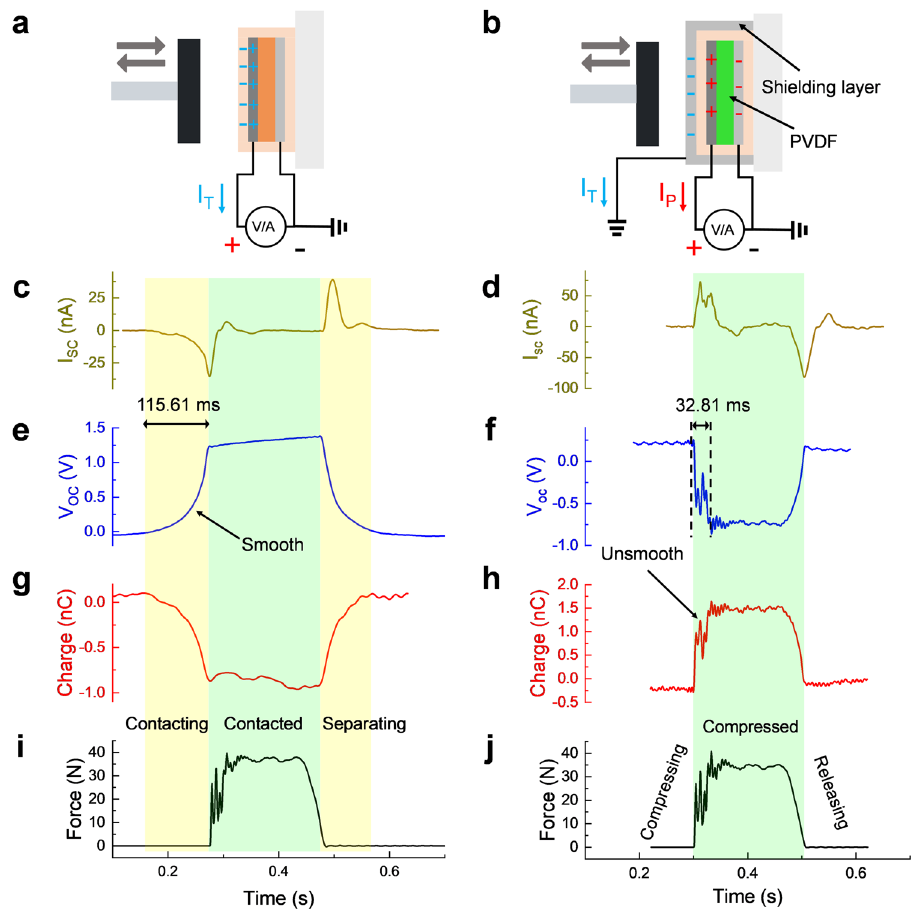
Fig. 3 Using loading force signal to differentiate the sole triboelectric signals and the sole piezoelectric signals. a Schematic diagram of measuring sole triboelectric signals from the PI-based device. Sole triboelectric signals including c short-circuit current, e open-circuit voltage, and g transferred charge are obtained under a certain i force signal, respectively. b Schematic diagram of measuring sole piezoelectric signals from PVDF-based device with a shielding layer. The conductive shielding layer is attached on the device ’ s surface, which can guide the induced triboelectric charges (I T ) fl ow to the ground and only piezoelectric signals (I P ) can be obtained in the front electrode. Sole piezoelectric signals including d short-circuit current, f open-circuit voltage, and h transferred charge are obtained under a certain j force signal,